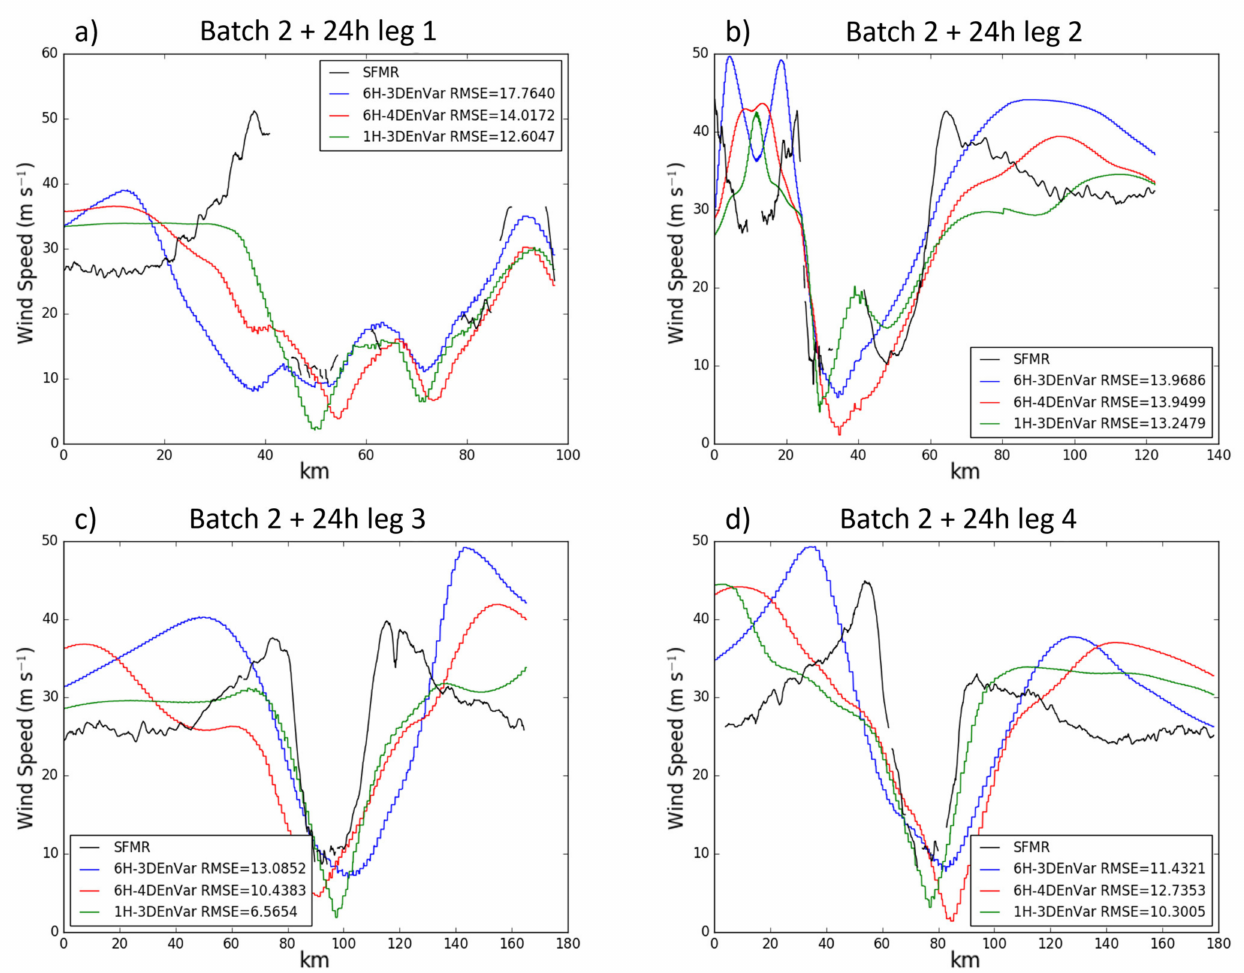
Figure 8. ( a – d ) SFMR wind speed (black) and model surface wind speed along the SFMR flight track for each leg. Forecast valid at 1800 UTC 16 September 2014 from forecast launched 24 h prior. The flight path is the same as in Figure